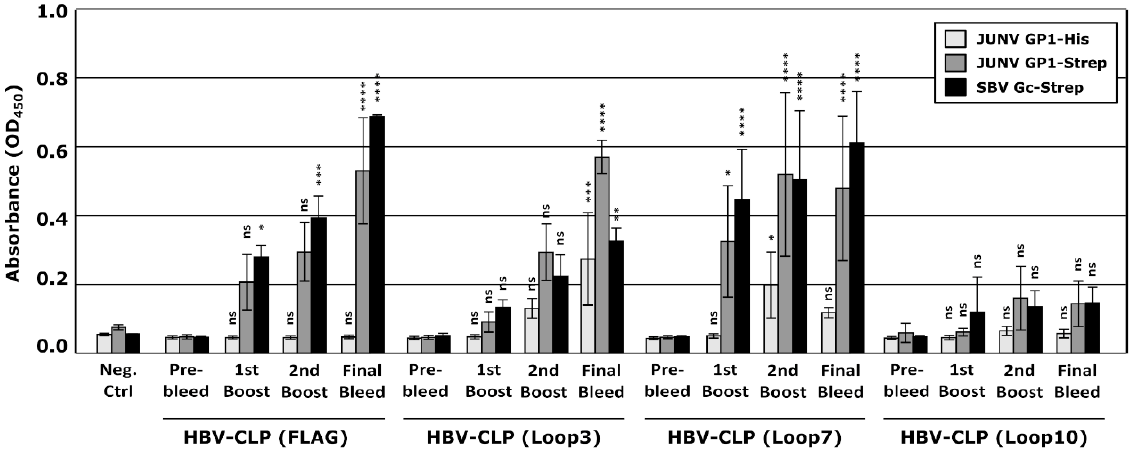
Figure 6. Development of antibodies following vaccination with Hepatitis B virus core-like particles (HBV-CLPs) expressing Junín virus (JUNV)-derived peptides. Blood samples were collected from rabbits either before immunization or 14 days after each of 3 immunizations with 80 μ g of purified HBV-CLPs expressing 1 of 3 JUNV-derived peptides (i.e., Loop 3, Loop 7, Loop 10), as indicated. Vaccination with HBV-CLPs without a JUNV-specific antigen (i.e., HBV-CLP (FLAG)) and a sample